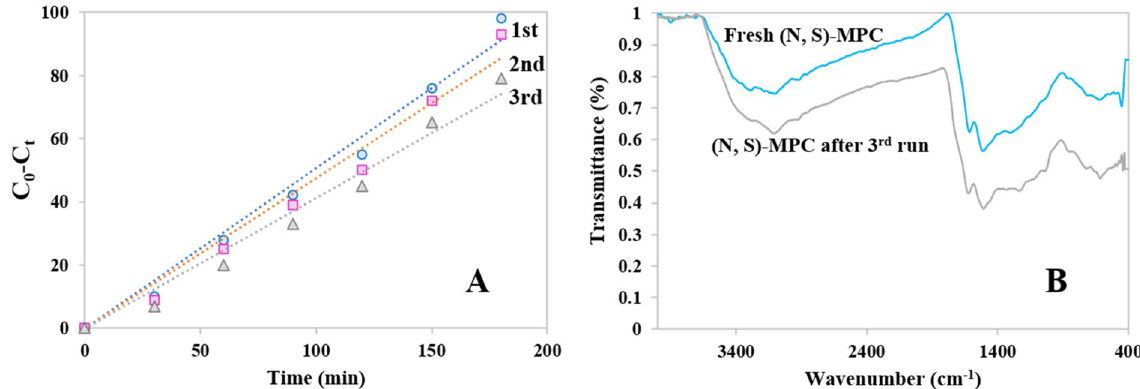
Figure 10. Recyclability tests of (N, S)-MPC for three runs ( A ), FT-IR spectra of fresh (N, S)-MPC, and (N, S)-MPC after three runs ( B